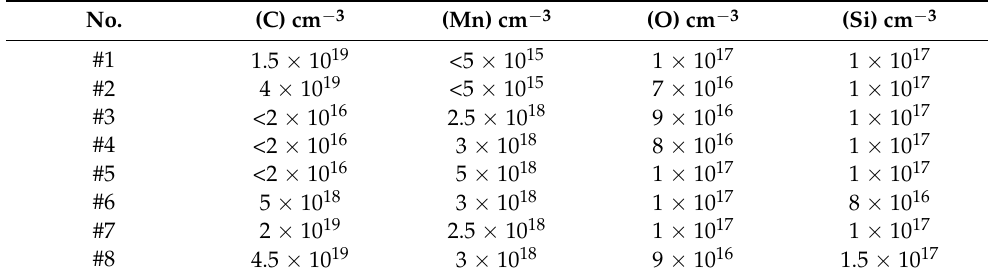
Table 2. SIMS data for ( 0001 ) surfaces of the samples.